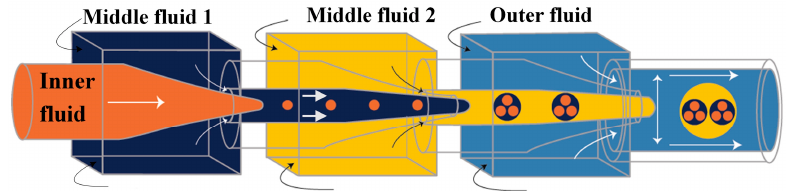
Figure 24. Generation of quintuple-component triple emulsions in a microfluidic device consisted of three co-flow drop makers [54].